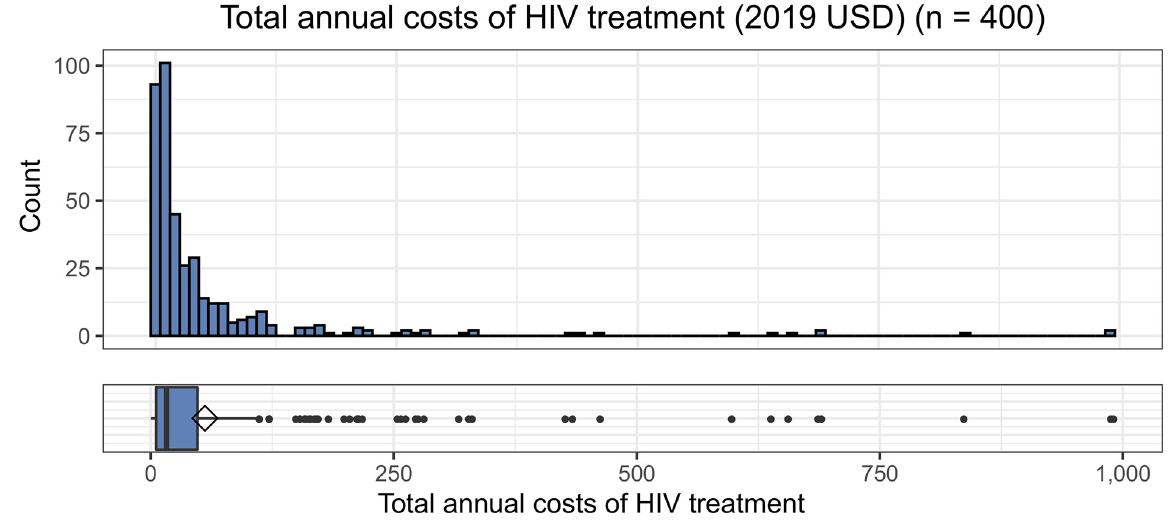
Fig 2. Total annual costs of HIV treatment (2019 USD) (n =